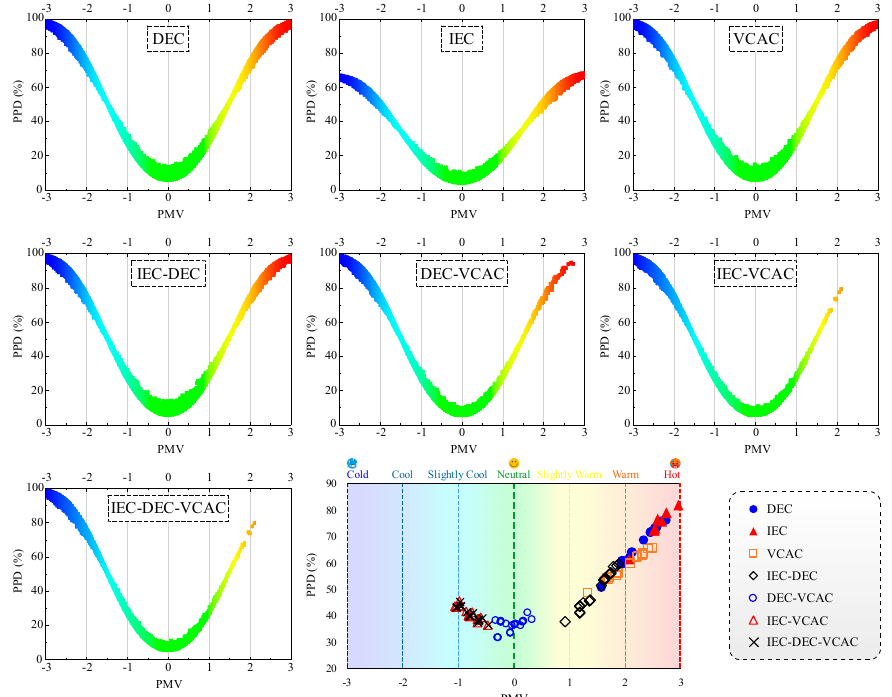
Figure 8. Annual variation of thermal comfort indices of the seven AC